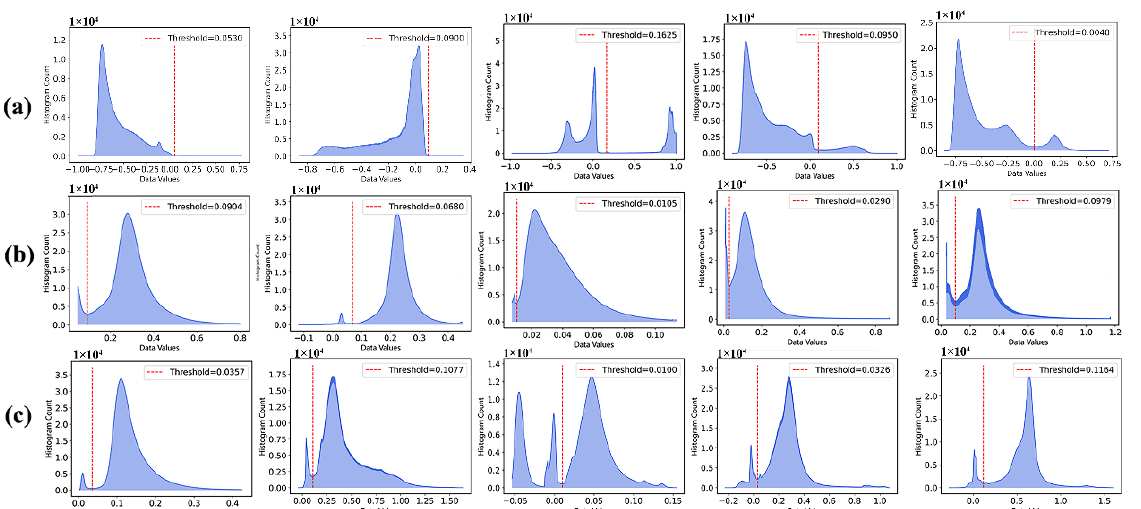
Figure 15. Comparison of histograms: ( a ) NDWI. ( b ) Co-polar band. ( c ) SOWI. In each panel, the red line represents the threshold.